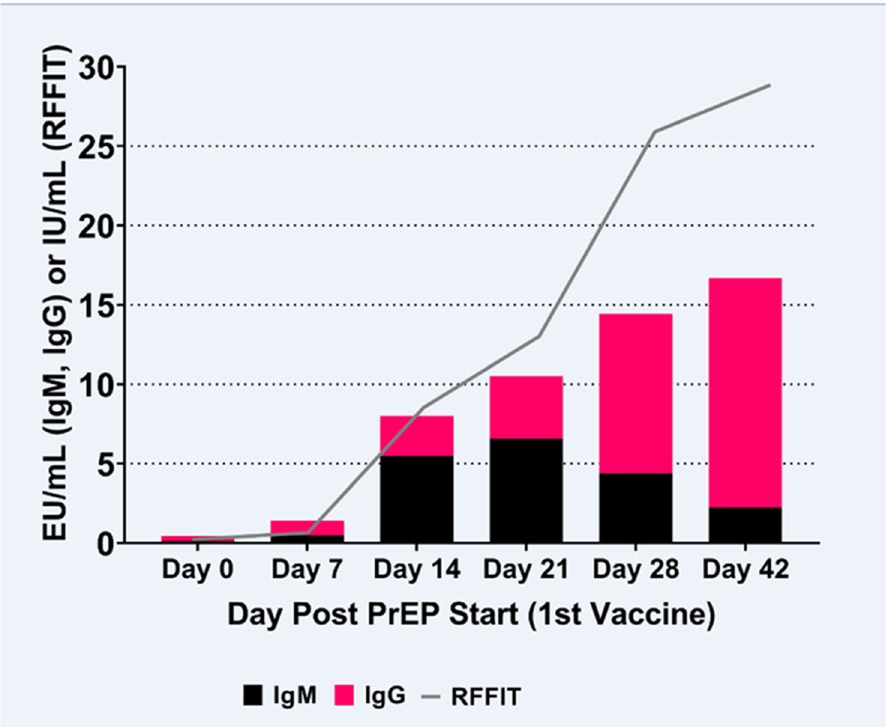
Figure 3. RVNA isotype switching kinetics displayed as average results per day post-vaccination (black bar = IgM, magenta bar = IgG, gray line = RFFIT). Note: Day 0 antibody activities in the assays are represented as ≤ values (non-zero values).